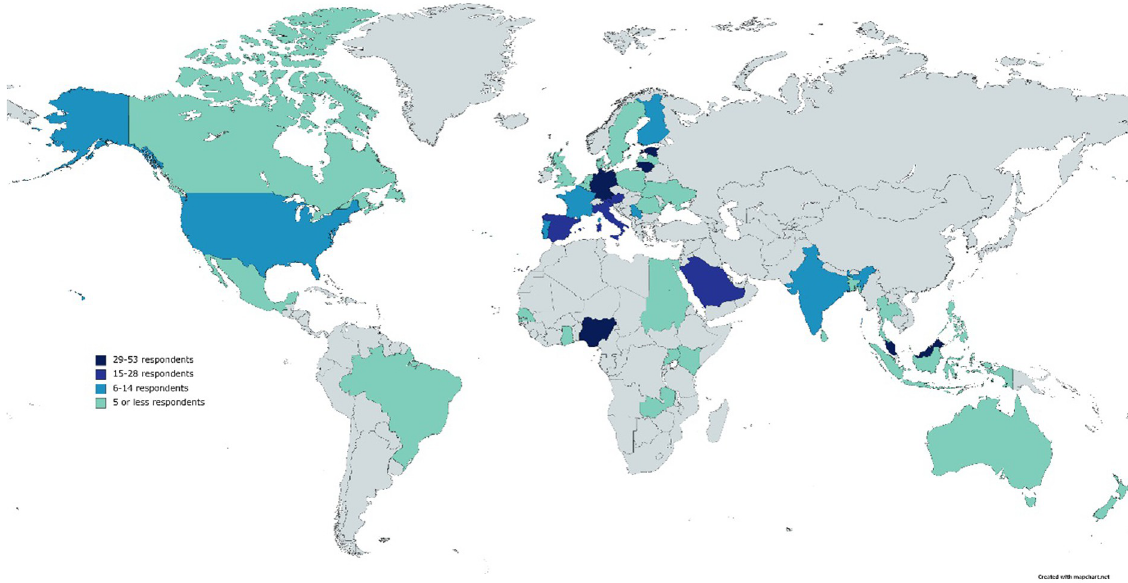
Fig 1. Survey participating countries and number of